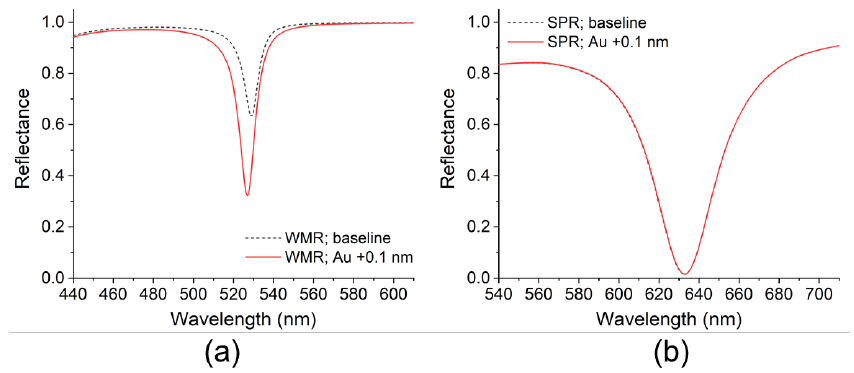
Figure 5. Simulation results of ( a ) waveguide-mode and ( b ) SPR sensors. Black broken and red solid lines represent before and after attachment of Au layer at surface of sensing plates, respectively.